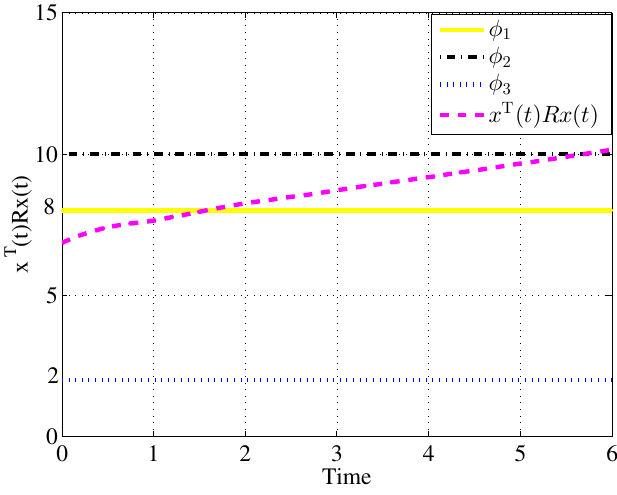
Figure 6. Illustration of x T ( t ) Rx ( t ) of system